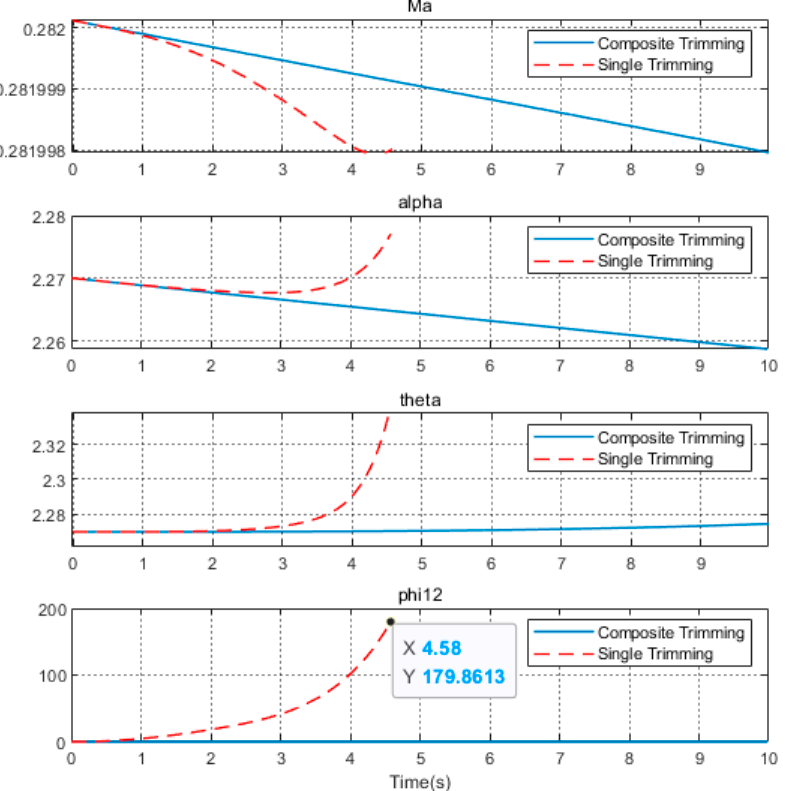
Figure 9. Wingtip-jointed aircraft system simulation results with different trim strategies.